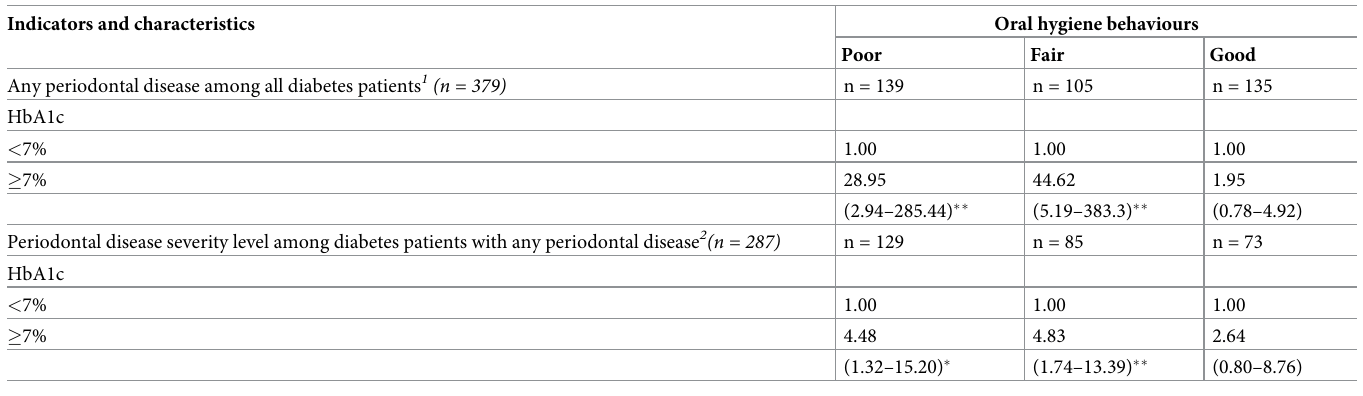
Table 4 shows the results of adjusted binary and ordinary logistic regression models for the association between any form of periodontal disease or its severity and control of diabetes interpreted by HbA1c measurements, after stratifying into three groups by oral hygiene behav- iours. Patients with poor or fair oral hygiene practices with poor control of diabetes are associ- ated with increased in the odds of a diagnosis of any and severe periodontal disease.